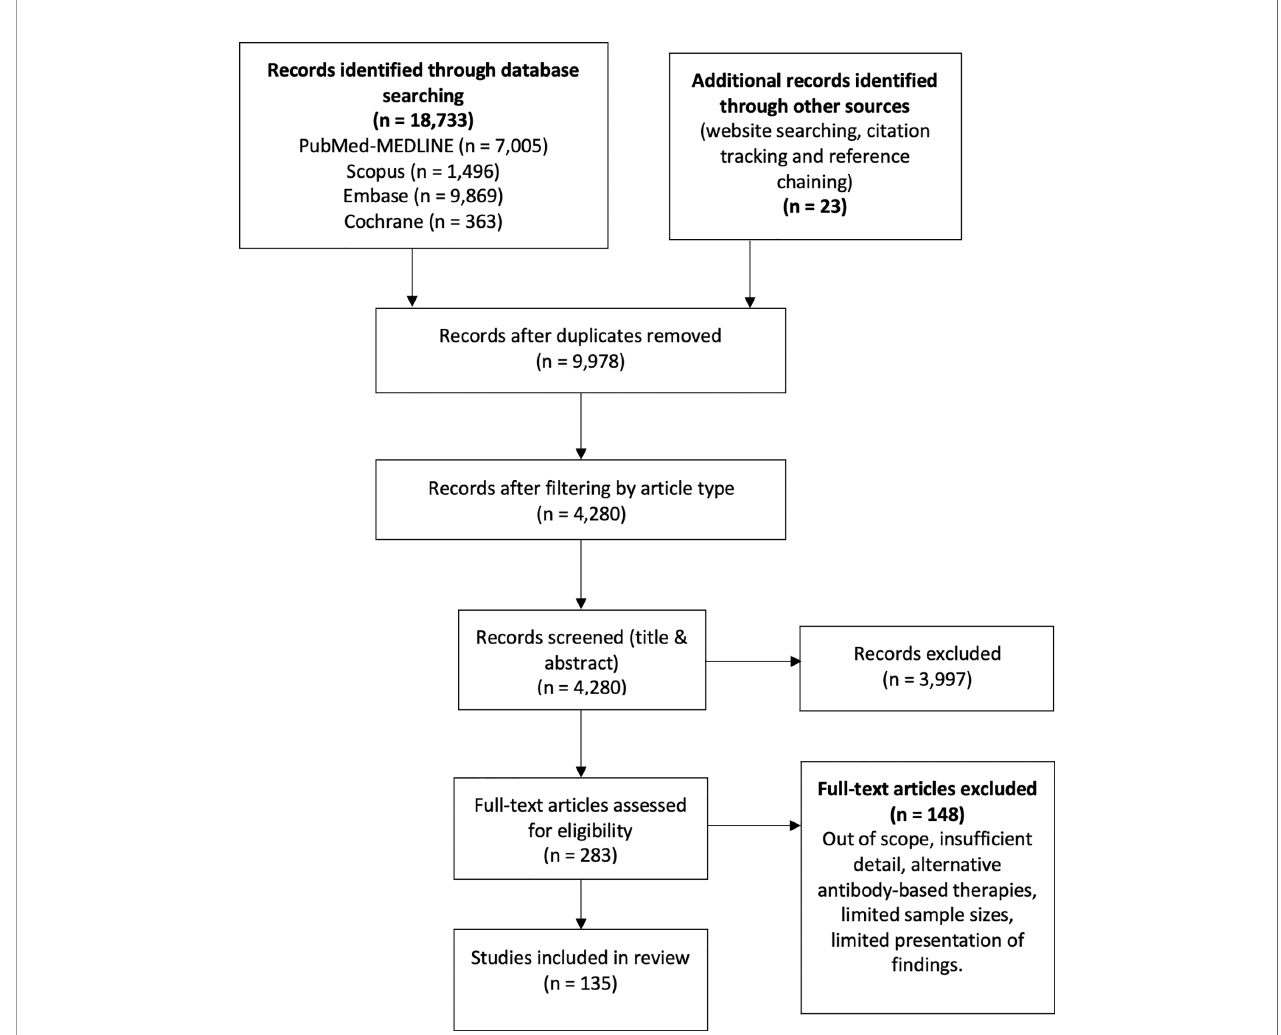
FIGURE 1 | The fl ow diagram describes the process of literature review on antibody kinetics, neutralization, antibody-dependent enhancement, seroprevalence and convalescent plasma in